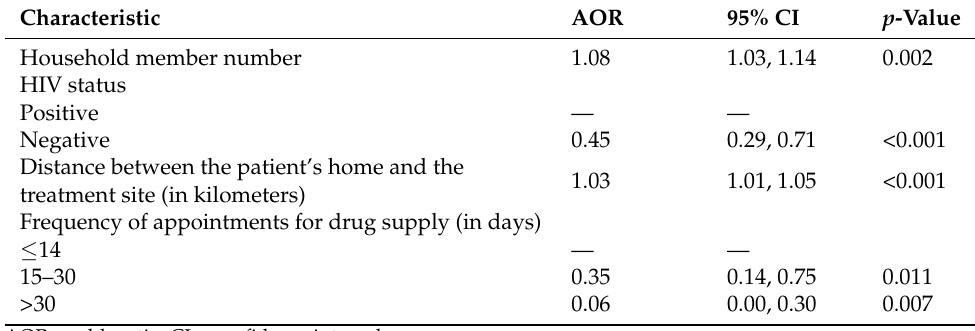
Table 6. Multinomial logistic regression anxiety/depression and sociodemographic and clinical characteristics.